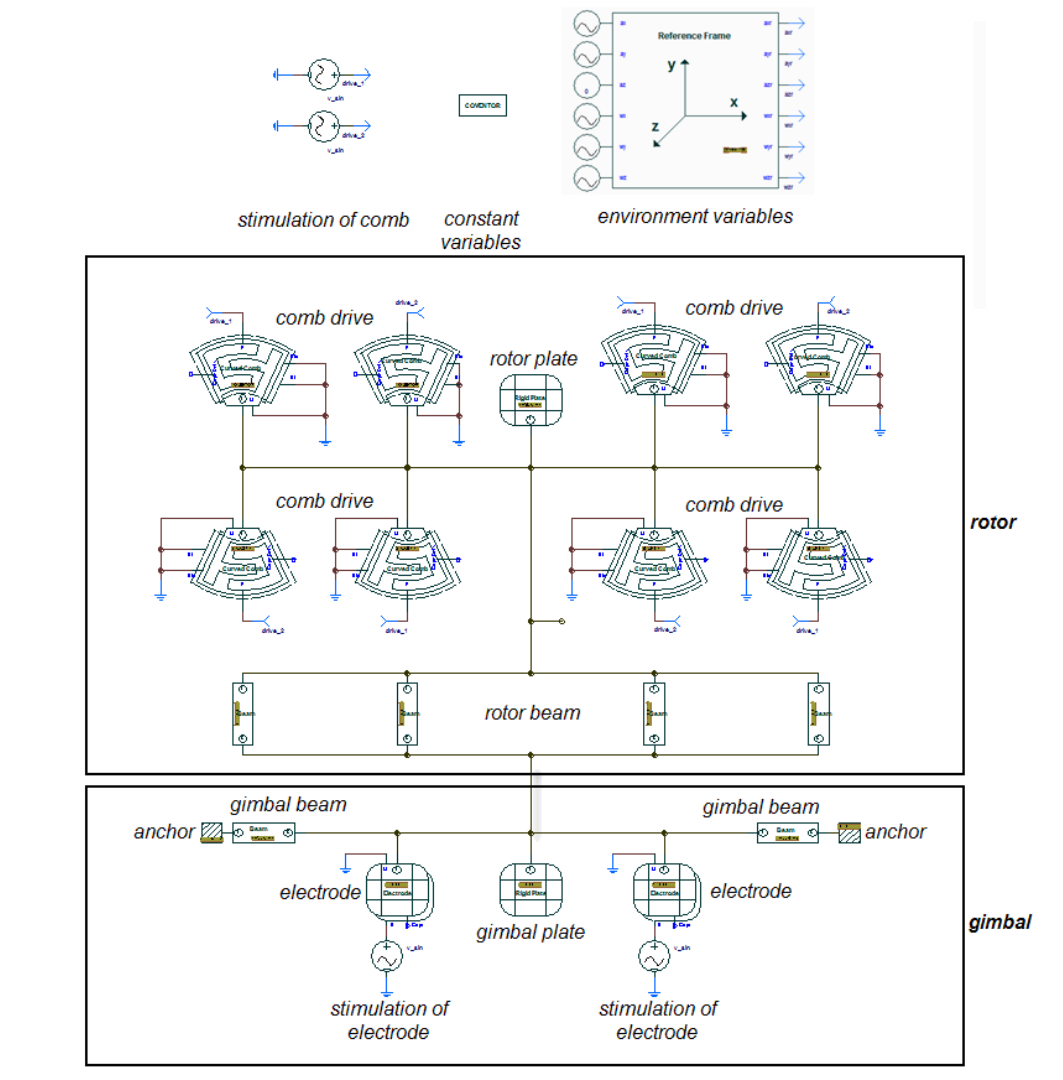
Figure 5. The system level model of MCMG established in Architect.